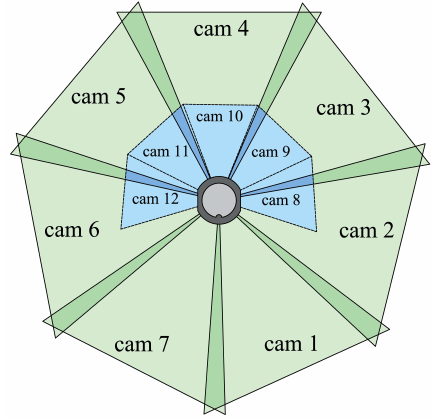
Figure 3: Camera numbering of the V10: “Cam 1” to “Cam 7” are cameras looking horizontal, “Cam 8” to “Cam 12” to the ground.